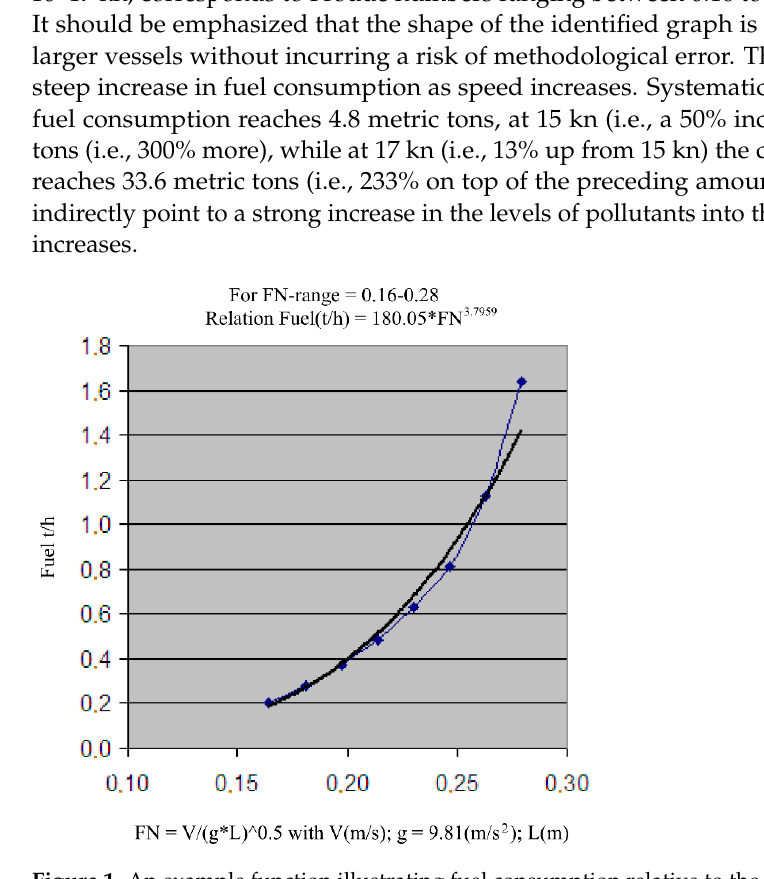
Figure 1. An example function illustrating fuel consumption relative to the ship’s speed expressed as a Froude number.